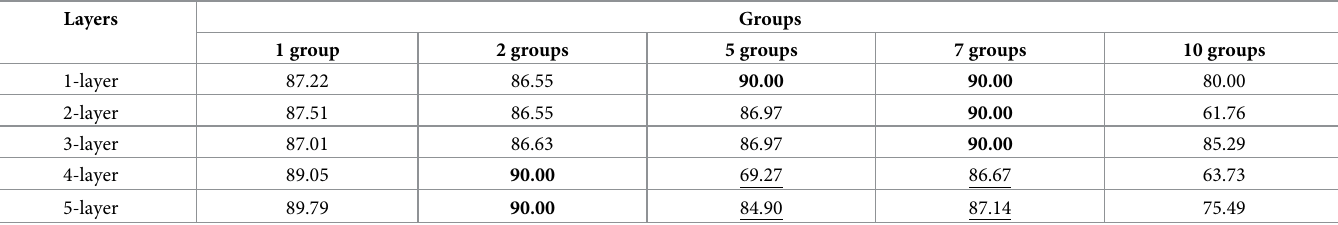
Table 6. Classification performance(%) at each layer where the bowling-ball class is positive. Layers